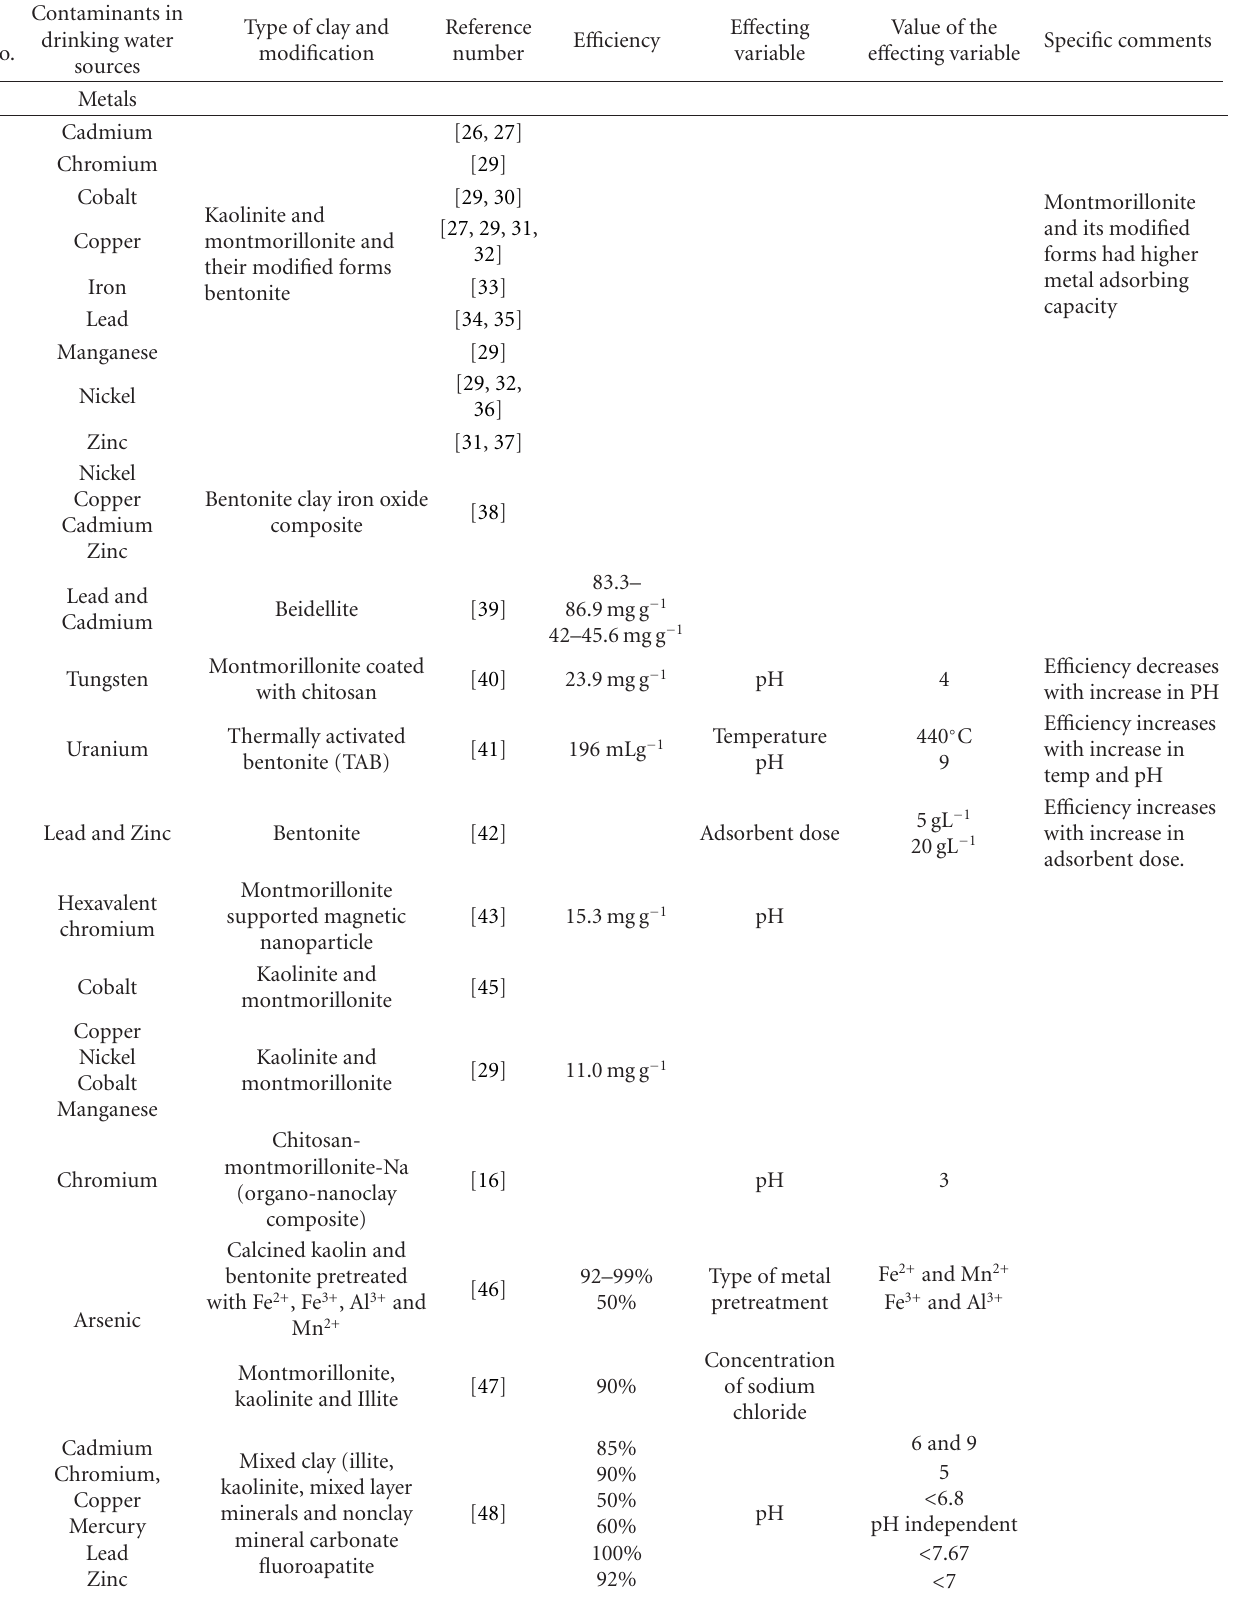
Table 1: Summary of the advances in application of natural clay and its composites in removing di ff erent contaminants from drinking water and its